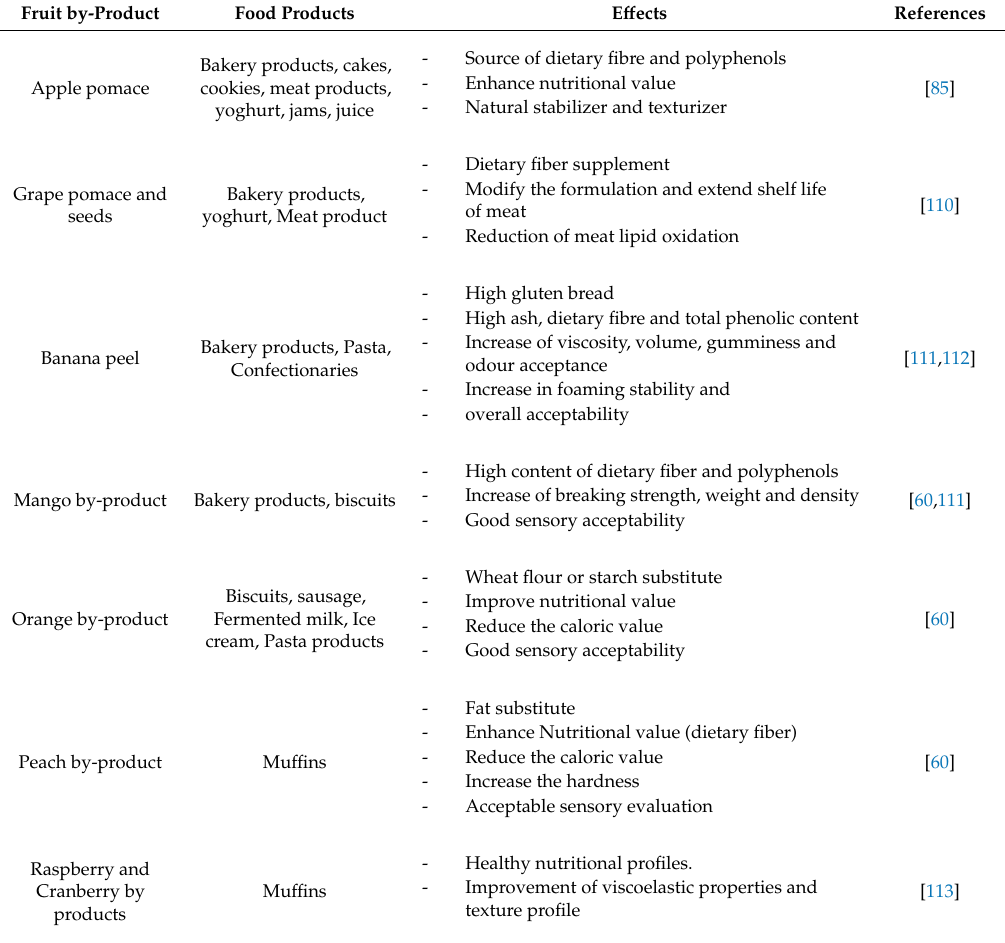
Table 5. Application of some fruit by-products into food